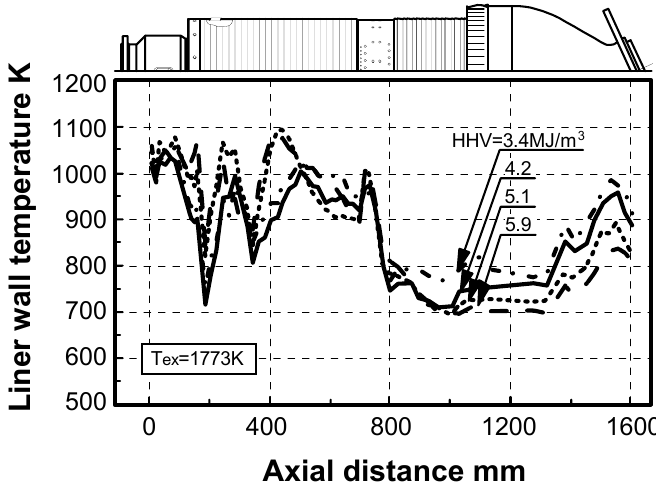
Figure 62. Combustor wall temperature